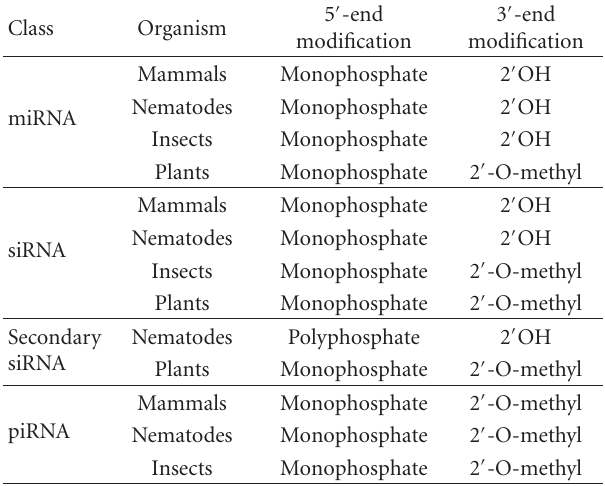
Table 1: Classes of small RNAs and their 5 (cid:3) - and 3 (cid:3) -end modifica-